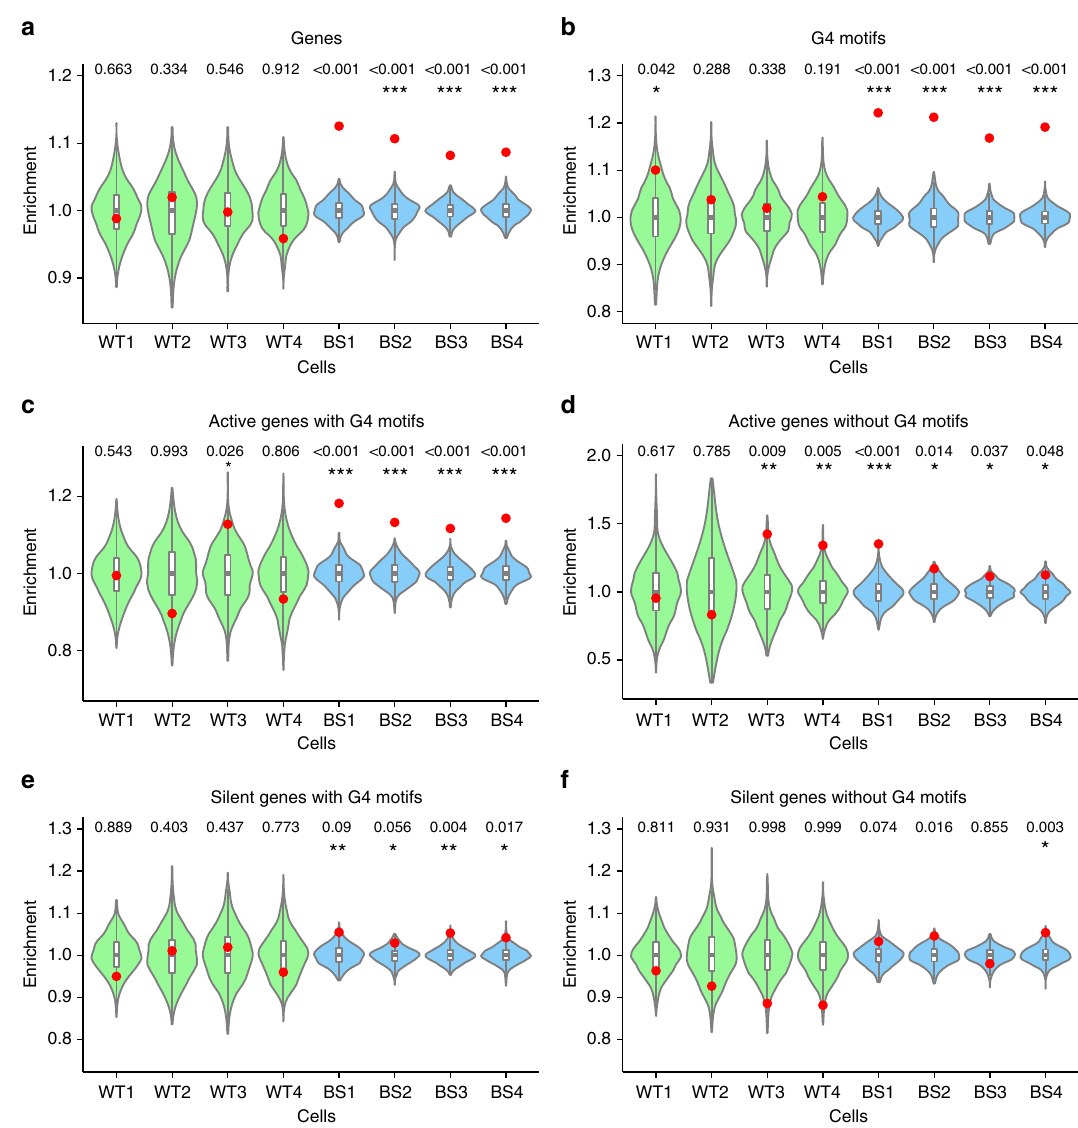
Fig. 2 Bloom syndrome SCEs are enriched at G4 motifs in active genes. Relative SCE enrichments (red points) over random distributions (violin plots) for SCEs that overlap with one or multiple a genes; b G4 motifs (G 3+ N 1 – 7 G 3+ N 1-7 G 3+ N 1-7 G 3+ ); c active genes containing one or more G4 motifs; d active genes without G4 motifs; e silent genes containing one or more G4 motifs; and f silent genes without G4 motifs. All values were normalized to the median permuted value for overlap of SCEs with FOIs (out of 1,000 permutations) and relative SCE enrichments over these values were plotted on the y-axis. p - values indicate the fraction of permuted overlaps (out of 1,000 permutations) equal to or higher than overlap with observed SCE regions. Signi fi cant p - values are indicated as follows: * p < 0.05, ** p < 0.01, *** p <